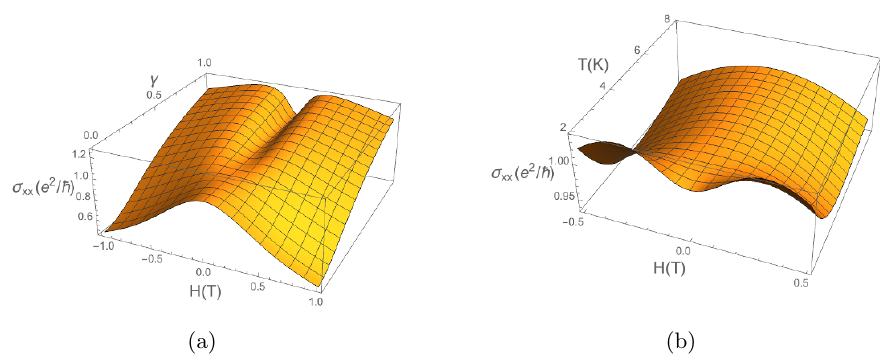
Figure 2 . Longitudinal conductivity (cid:27) xx (a) as a function of Magnetic doping ( (cid:13) ) and magnetic (cid:12)eld ( B ) at T = 2 K , (b) as a function of Temperature and magnetic (cid:12)eld at q (cid:31) (cid:13) = 0 : 7. In both case, we used (cid:12) 2 = 2747 and v F = 7 : 5 (cid:2) 10 4 m=s . We use the same number in all the (cid:12)gures ( (cid:22)m ) 2 appearing in this